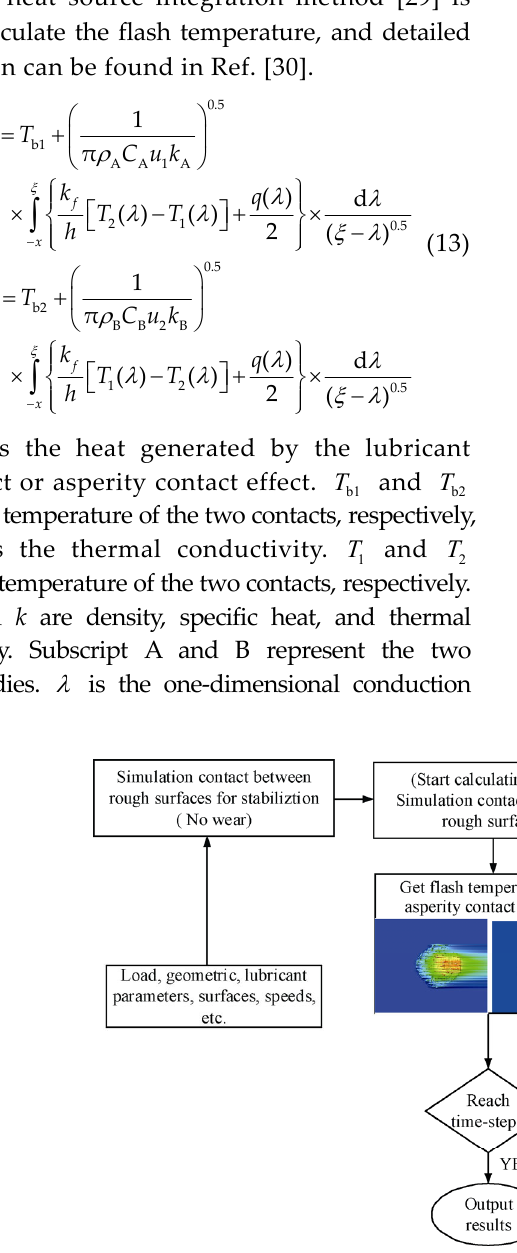
Fig. 1 Flow chart of the dynamic wear